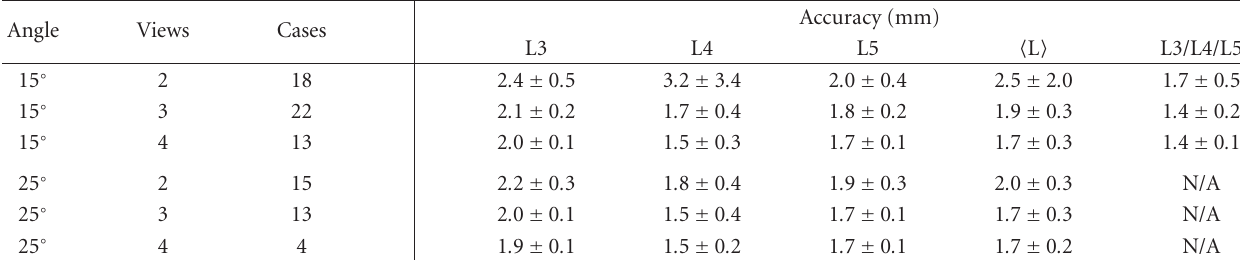
Table 4: Accuracy of the registration of the CT volume to pairs, triplets, and quadruplets of single-vertebra C-arm images for di ff erent minimal angles between image planes. The pooled performance is reported under the heading (cid:10) L (cid:11) . The results for single vertebrae can be compared to those for joint vertebrae